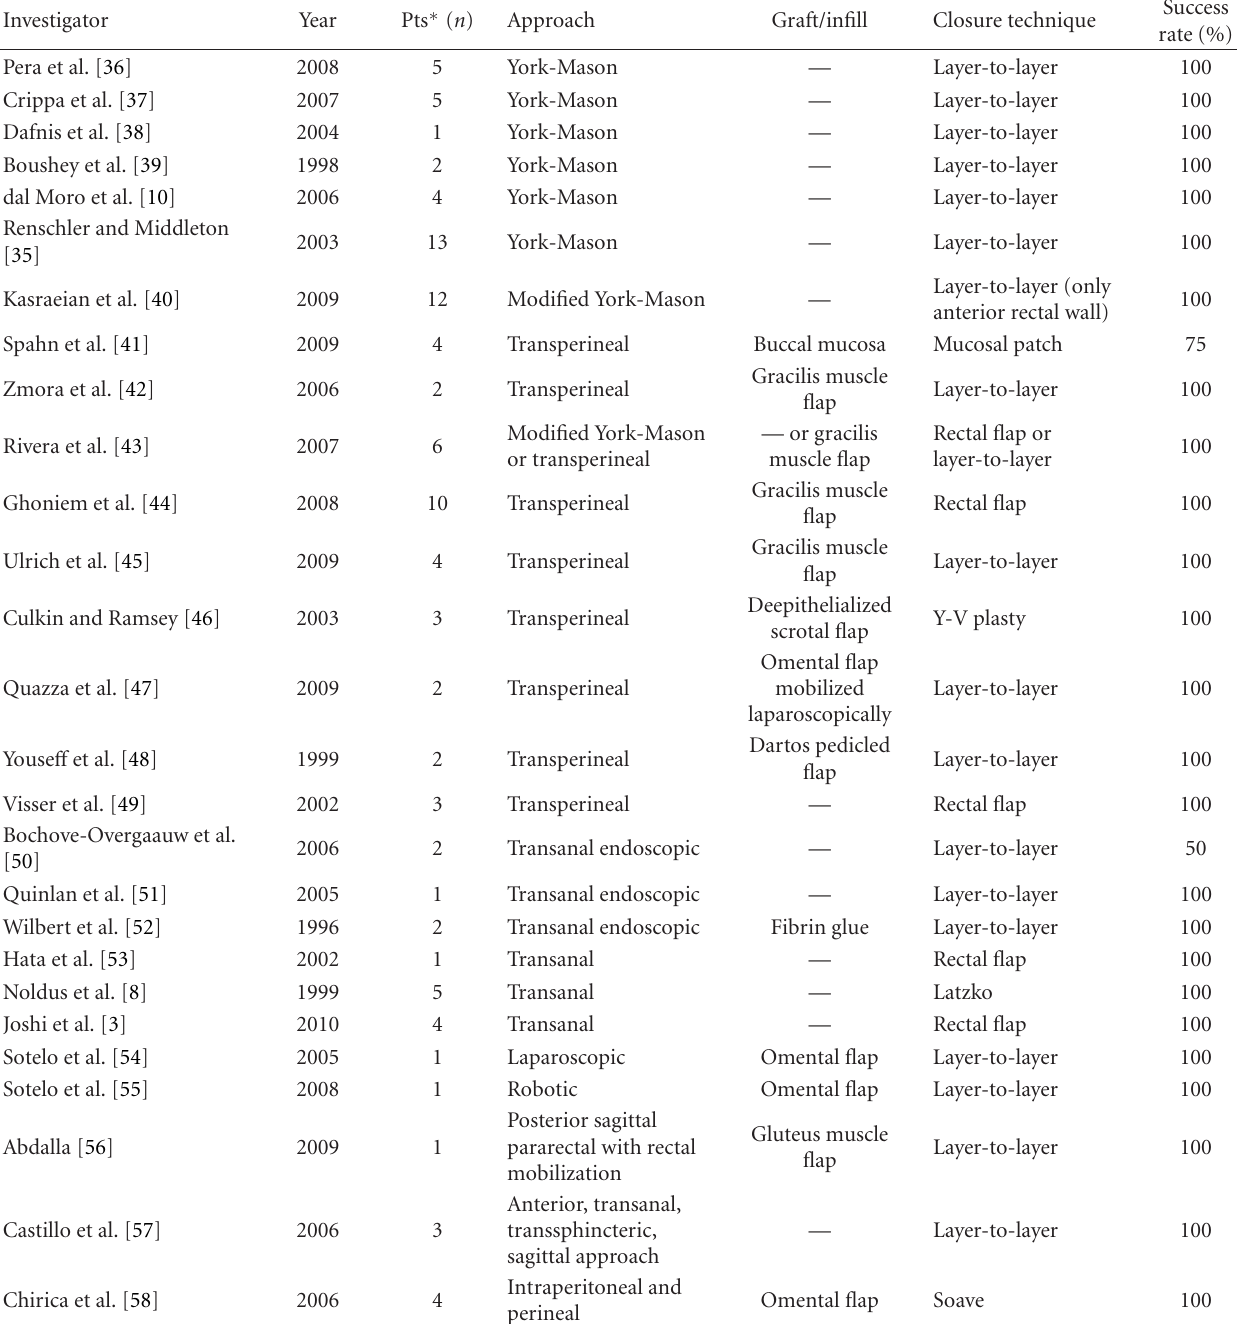
Table 2: Contemporary reports of RUF repair after